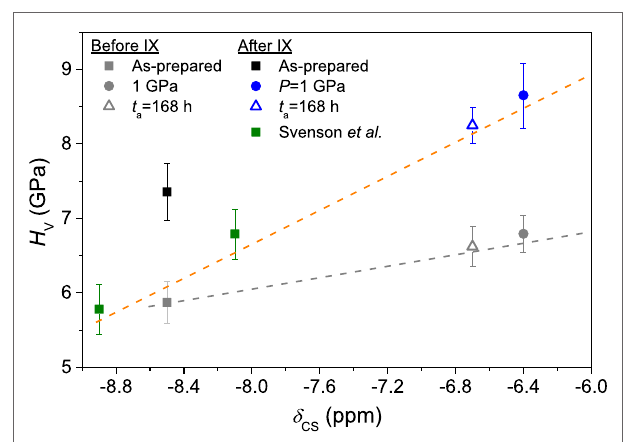
FigUre 15 | Vickers hardness ( H V ) as a function of 23 na chemical shift ( δ cs ) for samples before (gray symbols) and after ion exchange at 410°c (colored symbols) . H V of samples from Svenson et al. (2014a) have been re-measured at 0.5 N to be comparable with the values in the current study. δ CS is only measured on ion-exchanged samples, and δ CS of the samples before ion exchange is, therefore, represented by the δ CS value of their ion-exchanged analogs. The assumption that ion exchange does not significantly affect the local Na + environment (i.e., the value of δ CS ) is based on MD simulations of ion exchanged glasses (Tandia et al., 2012b). The dashed lines are guides for the eye, illustrating a positive correlation between H V and δ CS for the densified